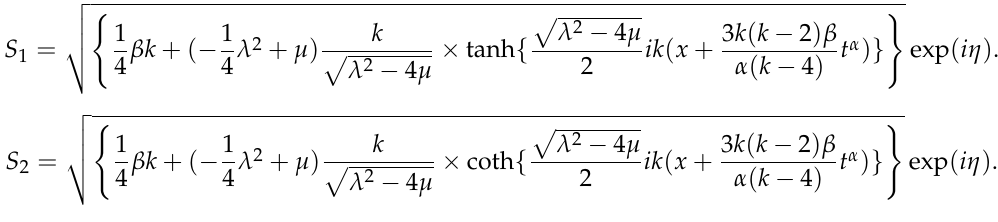
Figure 4. ( a – c ) Represent the imaginary part of wave via φ ( x , t ) of Equation (55) for the parametric situation α = 0.67, k 1 = 0.5, k 2 = 1, v = 2, A = 1, B = 2 and t = 0.5, 0.8, 1 for 2D graph.